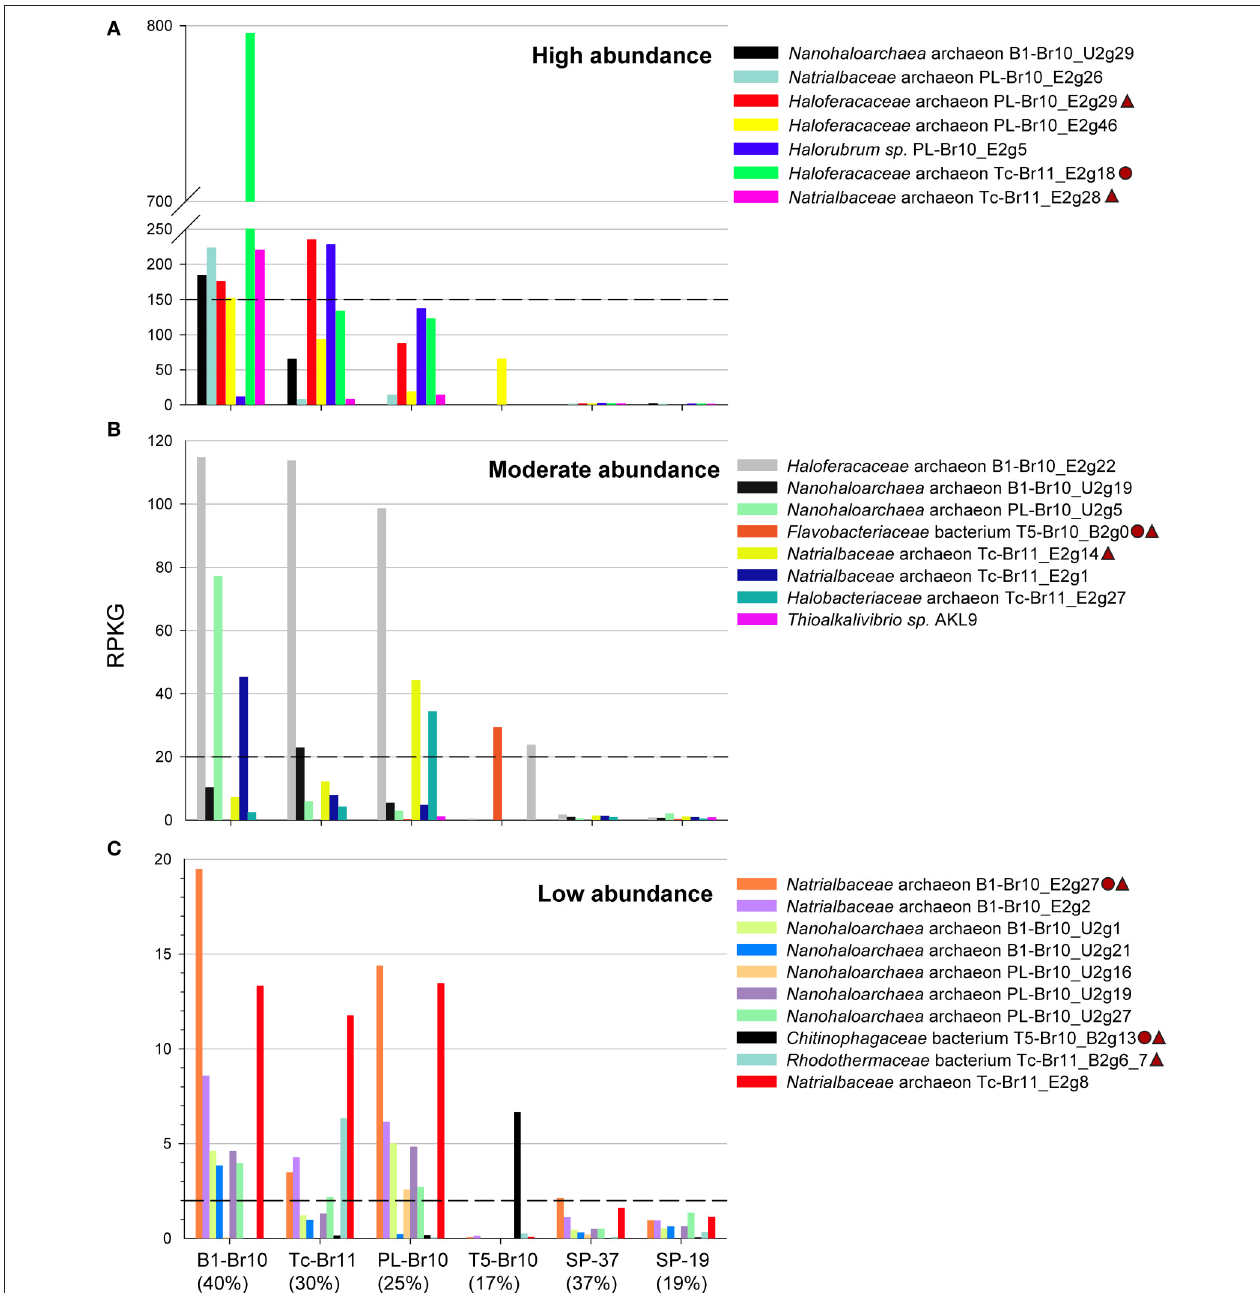
FIGURE 4 | Read recruitments ( < 95% N-identity) of reconstructed draft genomes and a reference draft genome from the genus Thioalkalivibrio from different metagenomic datasets. SP-37 and SP-19 are metagenomes from a crystallizer and an intermediate saline pond of the solar saltern in Santa Pola, Spain, with 37 and 19%, salinity respectively (Ghai et al., 2011). The salinity (in %) for the different soda brine metagenomes is given between brackets. Reconstructed draft genomes encoding putative chitinases are marked in the figure legend with a circle, those encoding putative cellulases with a triangle. RPKG, Reads Per Kilobase of sequenced reads per Gigabase of mapped reads. (A) Putative organisms with relatively high abundance ( > 150 RPKG), (B) with moderate abundance, (C) and with relatively low abundance ( < 20